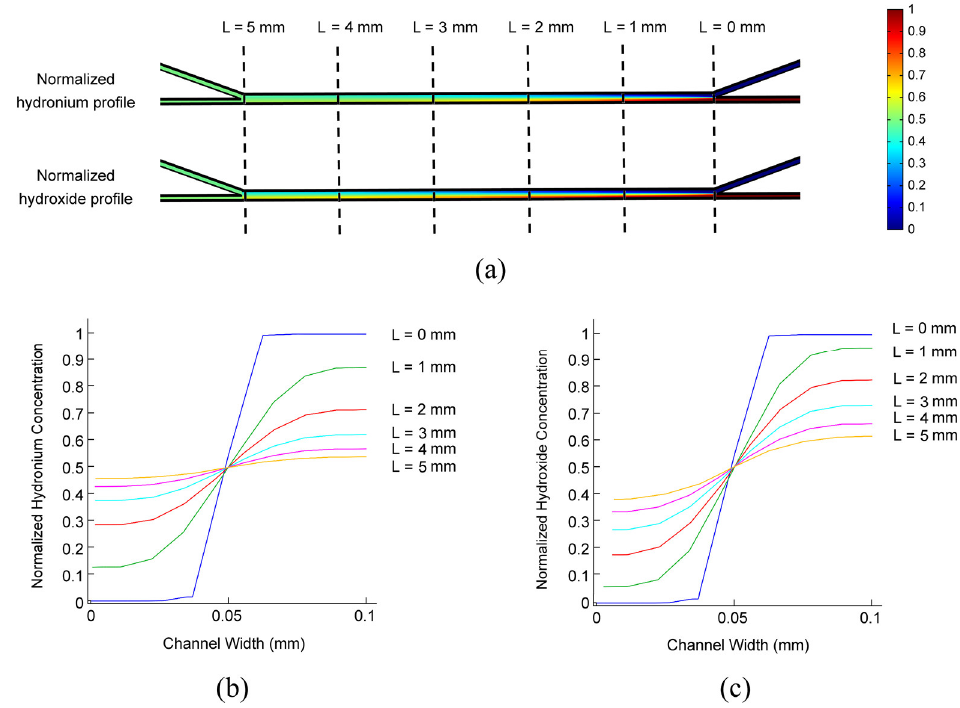
Figure 3. A normalized ionic concentration profile in the centric plane (Z = 50 μm in Figure 1). ( a ) Normalized ionic concentration profiles of hydronium and hydroxide. The ionic concentration is normalized by that of the flow-in solution. ( b ) The normalized hydronium concentration along the diffusion channel in the centric plane. ( c ) The normalized hydroxide concentration along the diffusion channel in the centric plane. The concentration is demonstrated in the direction of channel width (Y-direction in Figure 1). The outer channel of the water stream is noted as the start point, while the channel width is 100 μm. The volumetric flow rates for two laminar streams are 1 μL·min −1 .